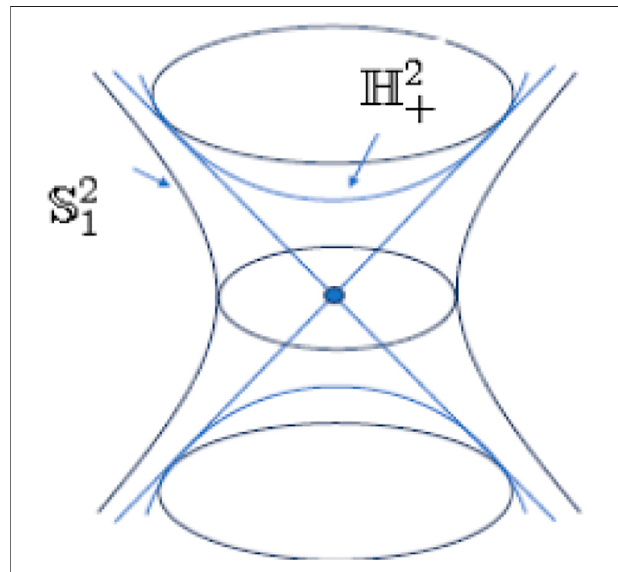
FIGURE 1 | Dual hyperbolic and dual Lorentzian unit